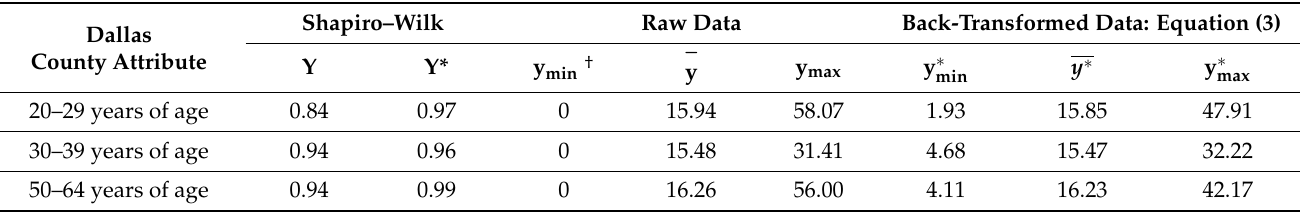
Table 2. Selected Manly transformed 2010 percentage attribute variables experiencing improvement of their individual correspondences with a Gaussian probability density